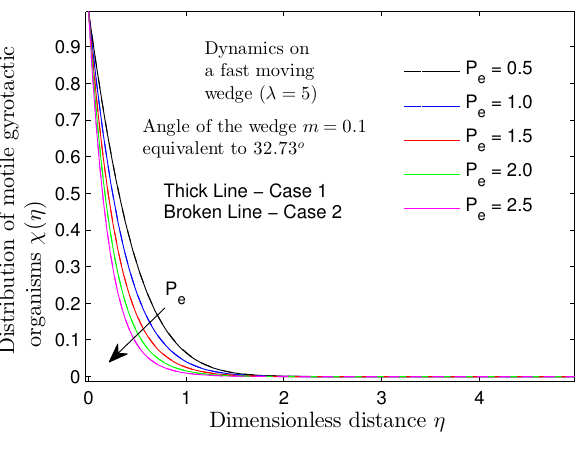
Figure 13. Distribution of motile gyrotactic organisms χ ( η ) within the entire domain on a static wedge with P e when λ = 0.